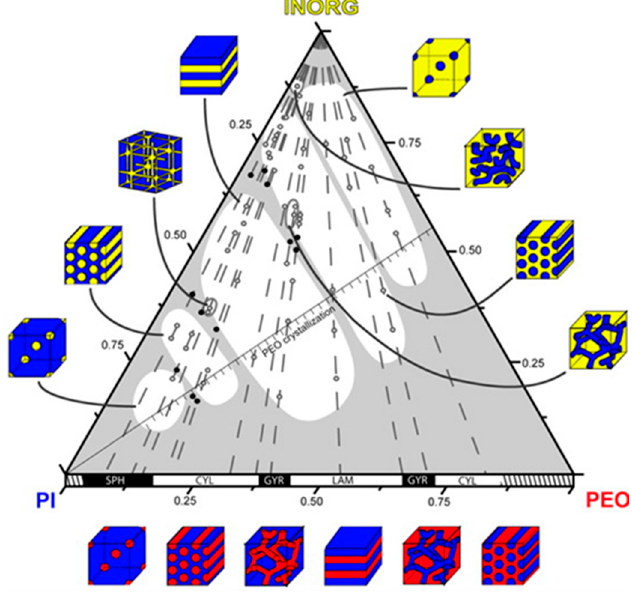
Figure 22. Ternary diagram mapping out the morphologies found for various composites directed by PI- b -PEO using (3-glycidyloxypropyl)trimethoxysilane (GLYMO) and aluminum sec-butoxide as inorganic precursors. At the bottom of the diagram, schematics of the morphologies found for the pure PI- b -PEO are shown. Hatched areas along the PI- b -PEO axis indicate areas where no data was available from the diblock copolymer diagram. Each white region within the diagram is labeled with a schematic representing the morphology of the composites formed. The yellow (light) regions in these schematic morphologies on the right and left are a representation of the PEO/inorganic domains. Closed dark points on a gray background indicate areas where biphasic behavior is observed. Reprinted from Reference [161]. (Copyright (2009) American Chemical Society).